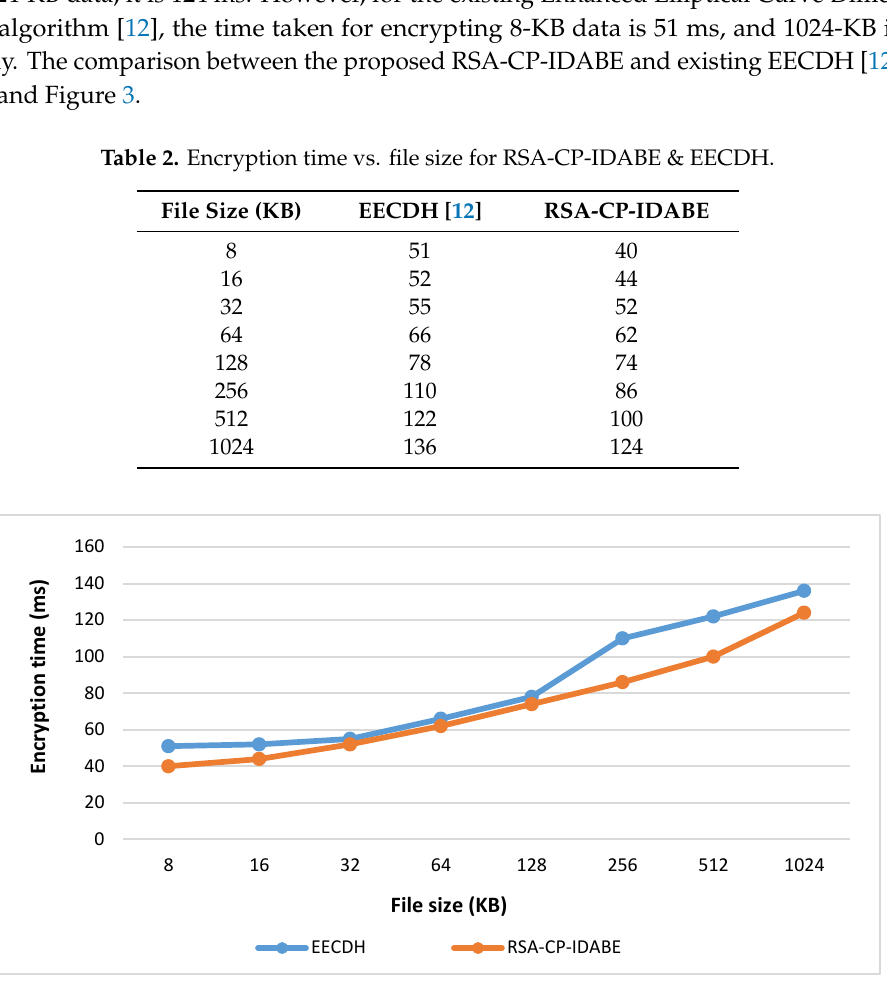
Figure 3. Comparison between the proposed RSA-CP-IDABE and EECDH for encryption time.